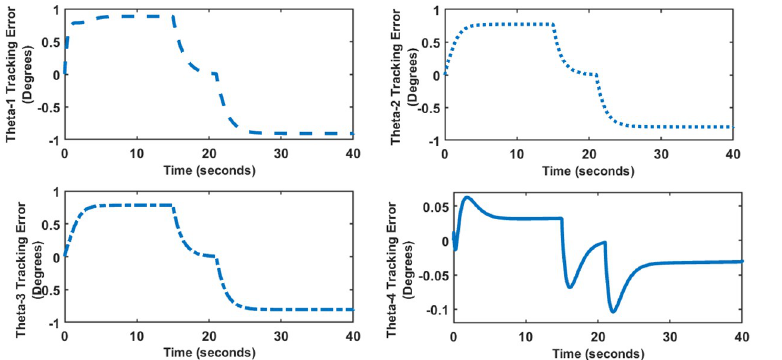
Fig 14. Tracking error for SFG-MIMO PI